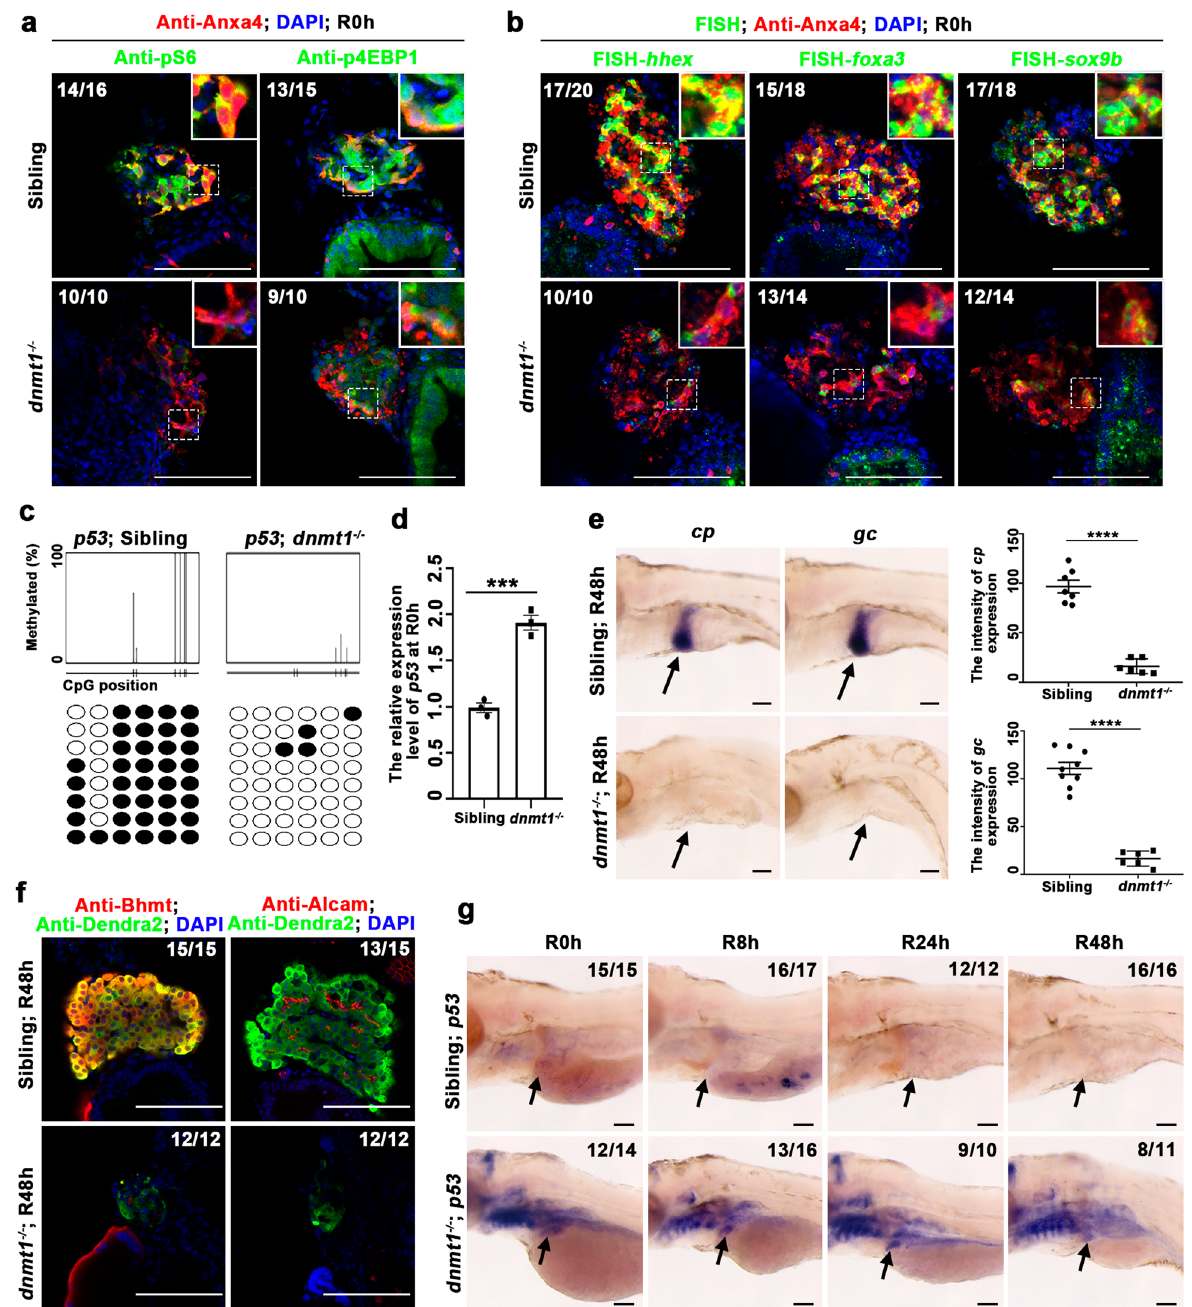
Fig. 7 The dnmt1 mutant blocks liver regeneration. a Single-optical section images showing the expression of pS6, p4EBP1, and Anxa4 in regenerating livers at R0h in dnmt1 mutant and sibling. Note that the mTORC1 signaling effectors pS6 and p4EBP1 are downregulated in dnmt1 mutant compared with the sibling. b Single-optical section images showing the FISH and antibody staining images of the expressions of hhex , sox9b , foxa3 , and Anxa4 in regenerating livers at R0h in dnmt1 mutant and sibling. c Bisul fi te sequencing analysis of DNA methylation at the p53 locus in DNA isolated from livers of dnmt1 sibling and mutant at R0h. d qPCR data showing the relative expression level of p53 in livers of dnmt1 mutant and sibling at R0h. e WISH images showing the expressions of cp and gc at R48h in dnmt1 mutant and sibling livers (arrows). Quanti fi cation of the intensity of gc and cp expressions in liver regions at R48h. f Single-optical section images showing the expressions of hepatocyte marker Bhmt, BECs marker Alcam, and Dendra2 in regenerating livers at R48h in dnmt1 mutant and sibling. g WISH images showing the expression of p53 at R0h, R8h, R24h, and R48h in dnmt1 mutant and sibling livers (arrows). Asterisks indicate statistical signi fi cance: *** P < 0.001; **** P < 0.0001 using t -tests analysis when compared to control. Numbers indicate the proportion of larvae exhibiting the expression shown. Scale bars: 100 µm; error bars, ±SEM. DAPI 4 ’ ,6-diamidino-2-phenylindole, FISH fl uorescent in situ hybridization, R regeneration time after the withdrawal of